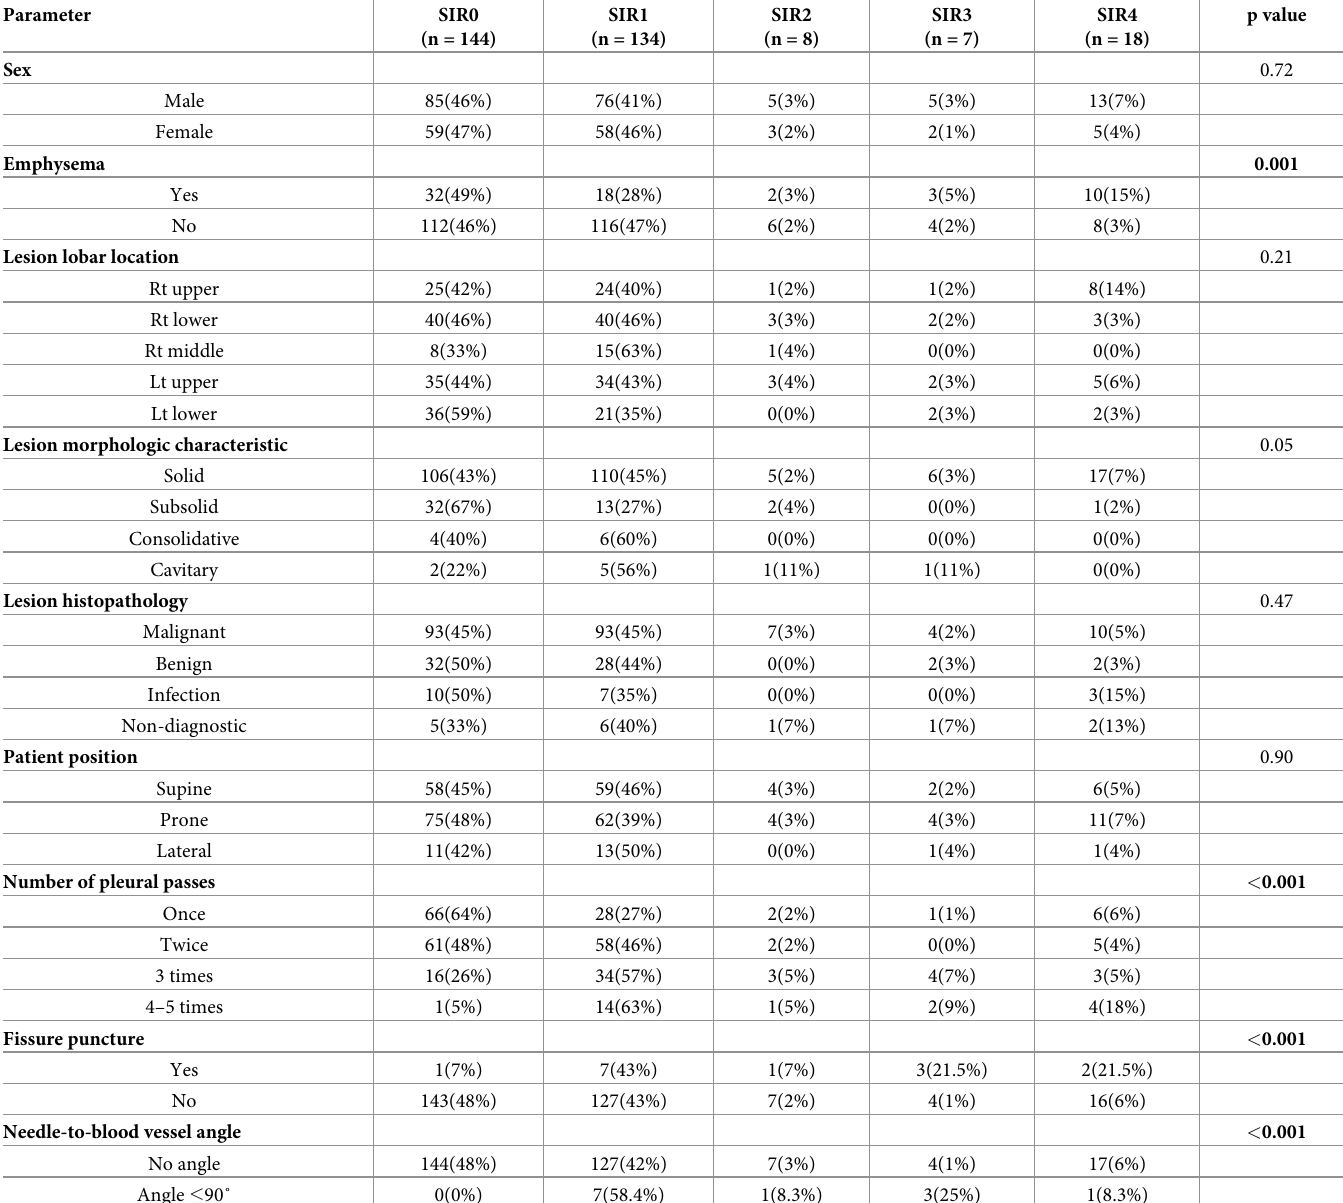
Table 3. Chi-square tests of ordinal and nominal parameters in relation to SIR classification (n = 311).